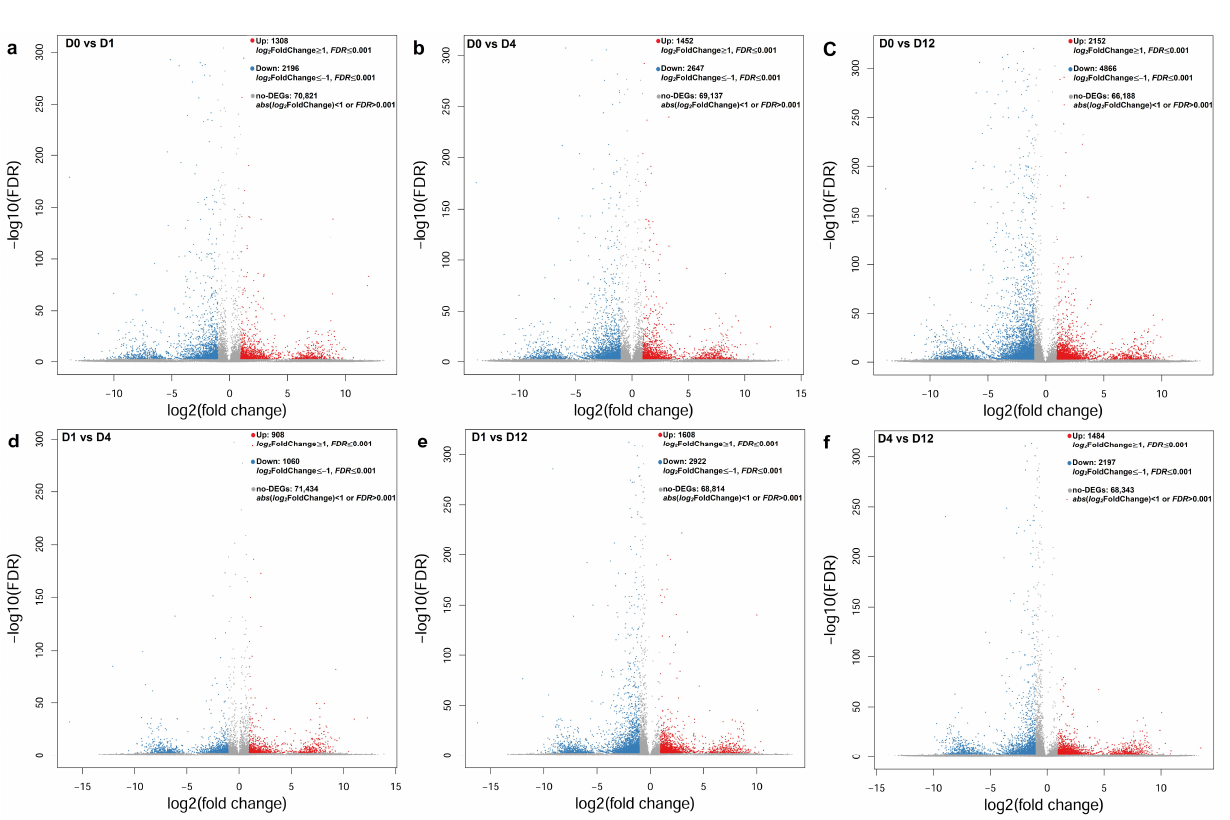
Figure 3. Distribution of the differentially expressed genes between drought-stressed samples. ( a ) Volcano plot of DEGs between D0 and D1 samples. ( b ) Volcano plot of DEGs between D0 and D4 samples. ( c ) Volcano plot of DEGs between D0 and D12 samples. ( d ) Volcano plot of DEGs between D1 and D4 samples. ( e ) Volcano plot of DEGs between D1 and D12 samples. ( f ) Volcano plot of DEGs between D4 and D12